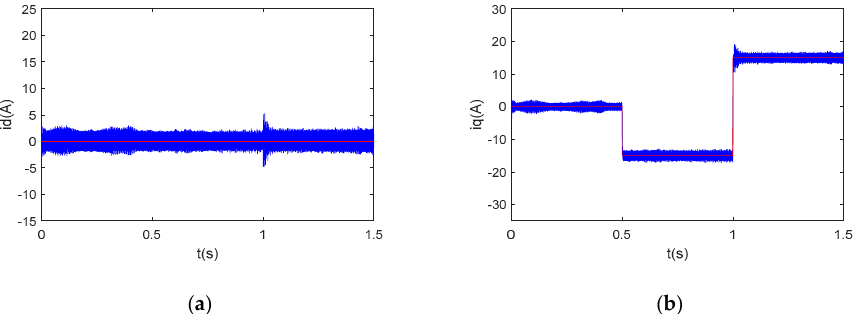
at 12,000 rpm. ( a ) d-axis current; ( b ) q-axis current.